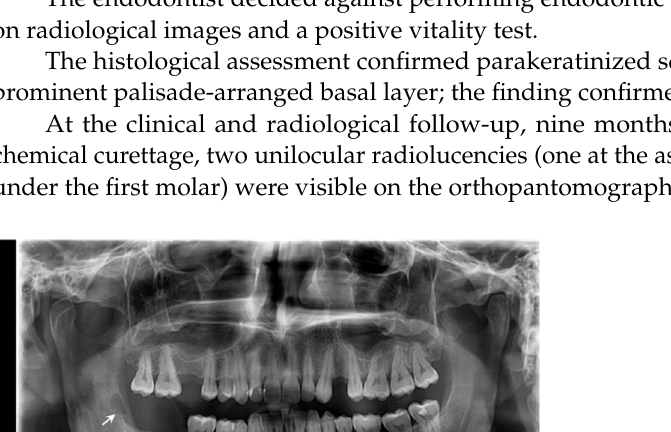
Figure 6. The radiological aspect: ( a ) Orthopantomography shows the healing process in the ascendant ramus, and the remaining osteolytic lesion at the apical region of the first and second mandibular molars (arrows), one year after marsupialization; ( b ) The CBCT, sagittal view indicates unmodified bone structure near the molar #46 apices; ( c ) The CBCT, sagittal view of molar #47 demonstrates the lesion contact and the enlarger of periodontal space.